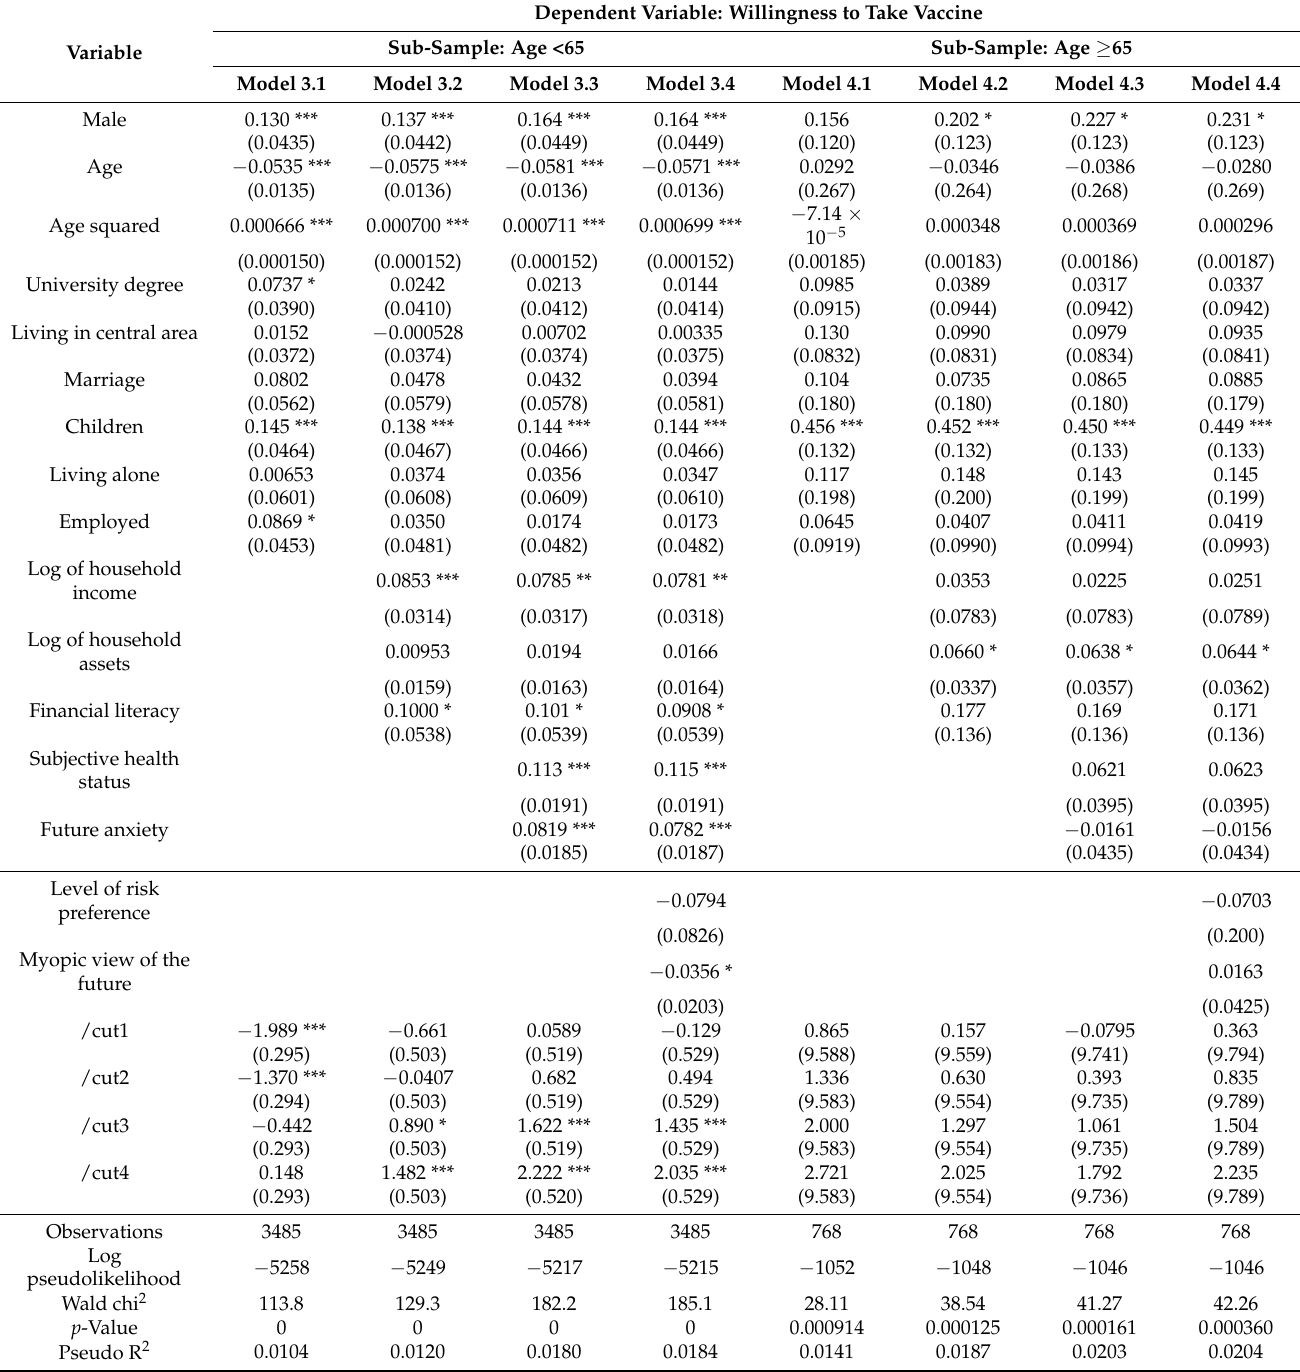
Table 7. Ordered probit model regression results (subsample analysis: